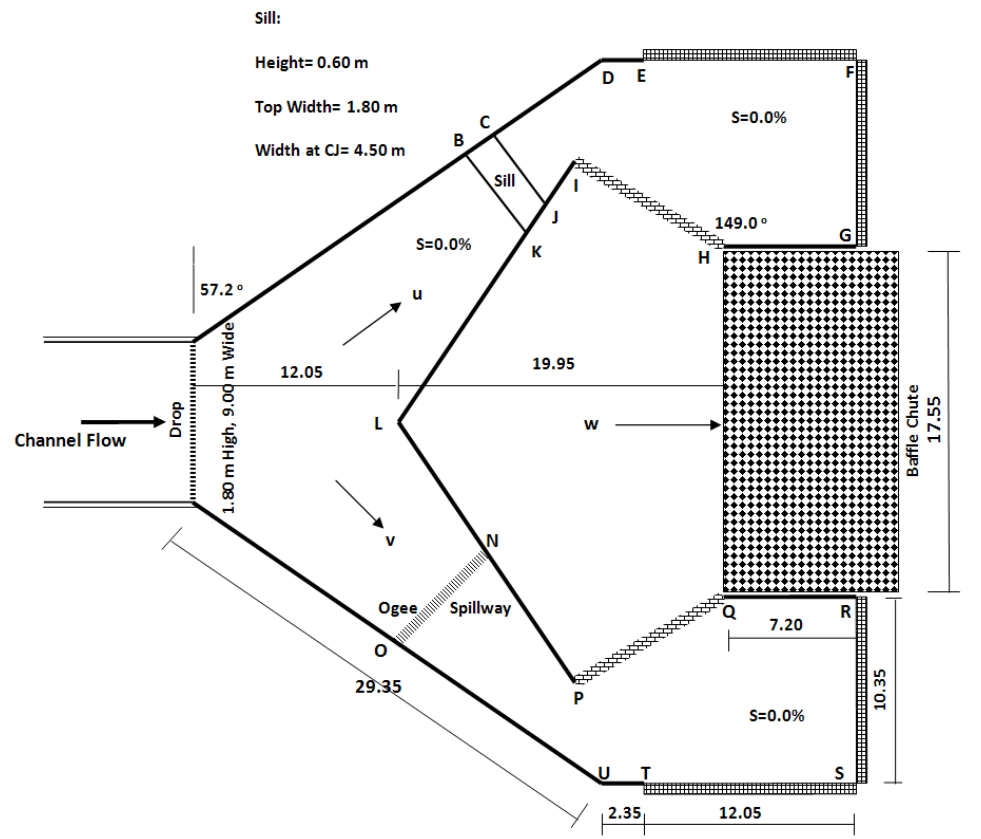
Figure 5. Layout and main dimensions of the design in